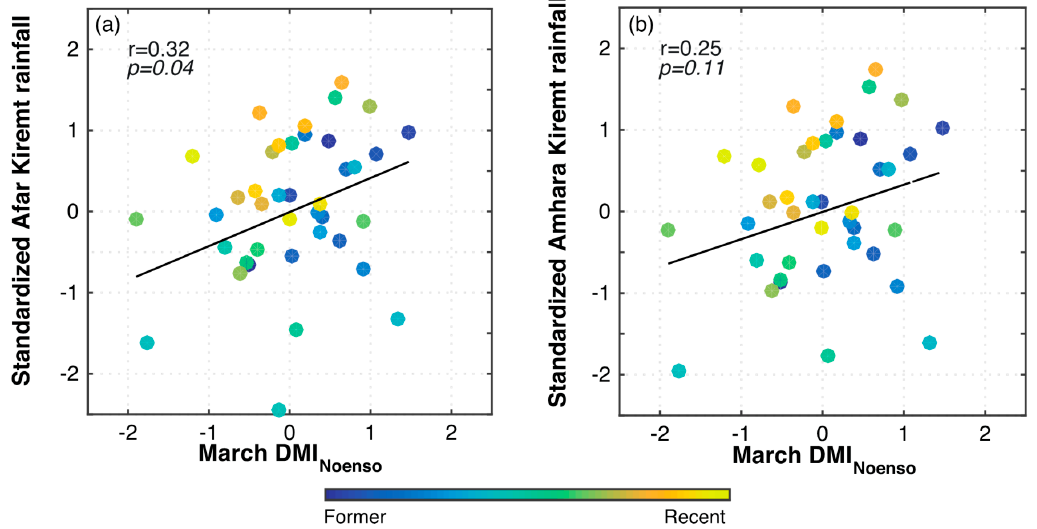
Figure 6. Monthly correlations between regional Kiremt rainfall and DMI NOENSO during the preceding month of March for ( a ) Amhara and ( b ) Afar. Color shades represent individual years between 1966 and 2006.